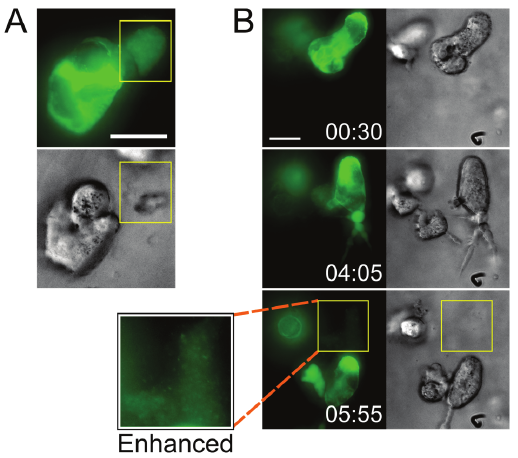
Figure 4. Infected cells deposit virus particles into pools within their surrounding stroma. ( A ) A CEM-SS syncytium in Matrigel culture releases a very dense accumulation of Gag-iGFP puncta into a cell-free pocket (area bounded by yellow box; still from Movie S7); ( B ) A CEM-SS syncytium in Matrigel culture migrates across the field, leaving behind a trail of dense Gag-iGFP puncta (area bounded by yellow box), shown also at 2× magnification and with brightness enhanced in a white-boxed inset (see also Movie S9). Scale bars = 20 μ m. Elapsed time in h:min. Gag-iGFP signal is pseudocolored in green. Brightfield images are in shades of gray.